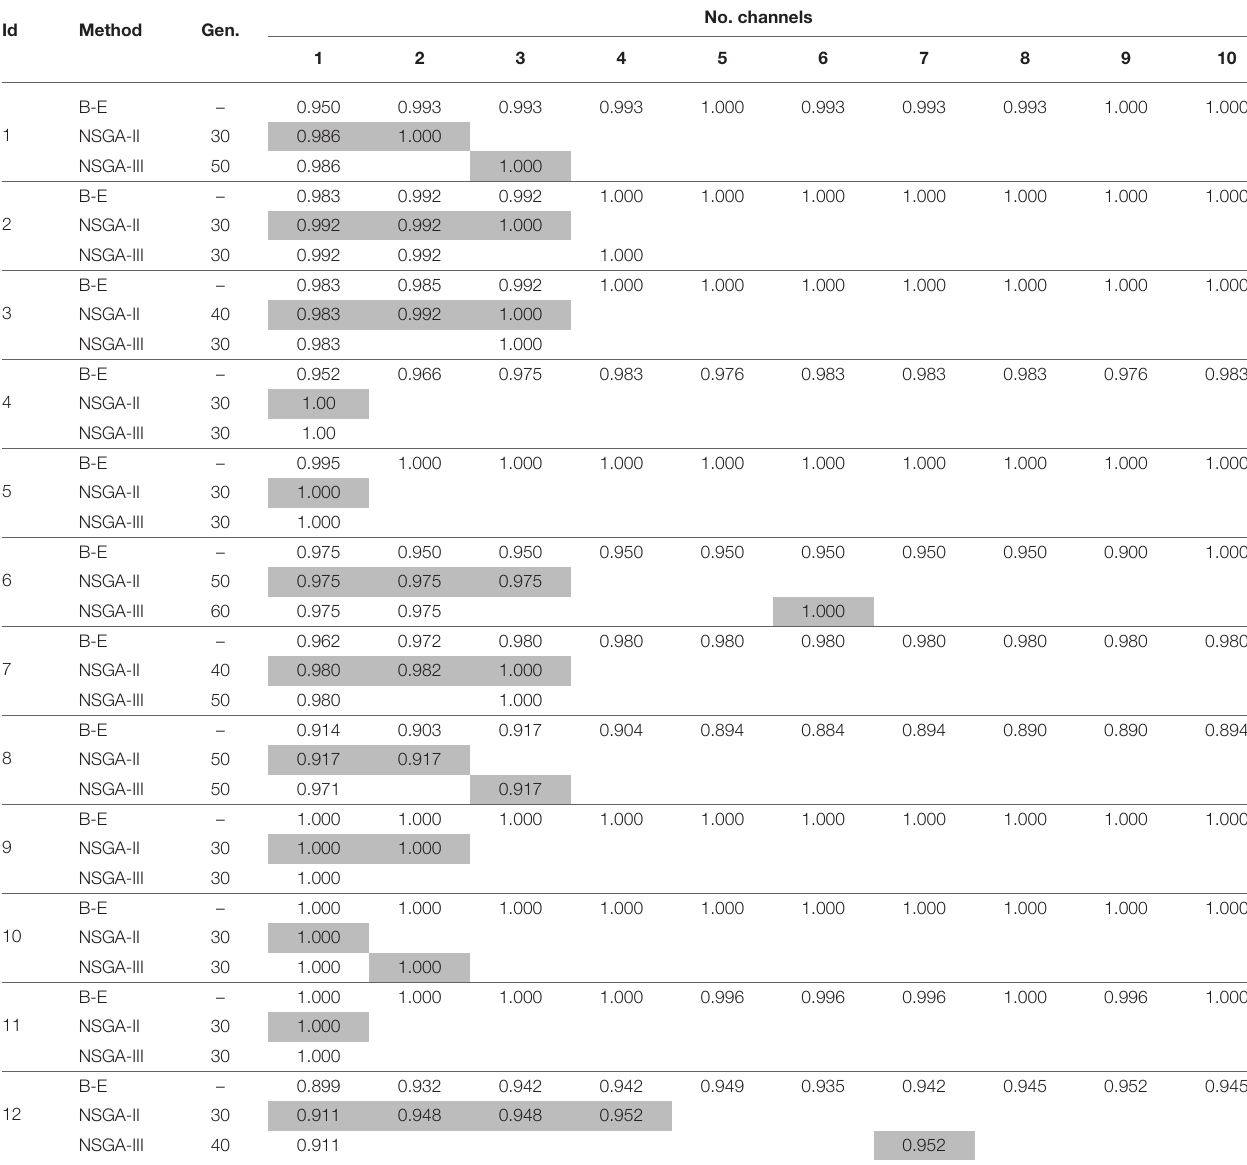
TABLE 3 | Accuracies obtained using DWT for feature extraction with NSGA-II and NSGA-III for EEG channel selection (subjects